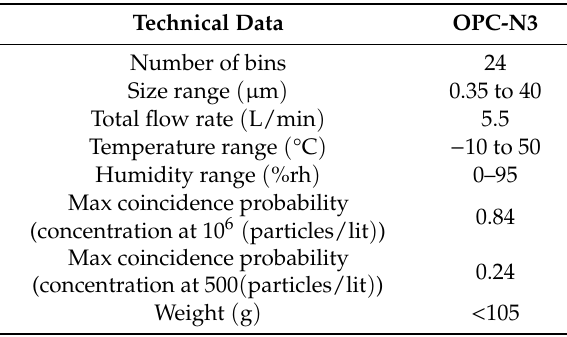
Table 1. OPC-N3 technical specifications